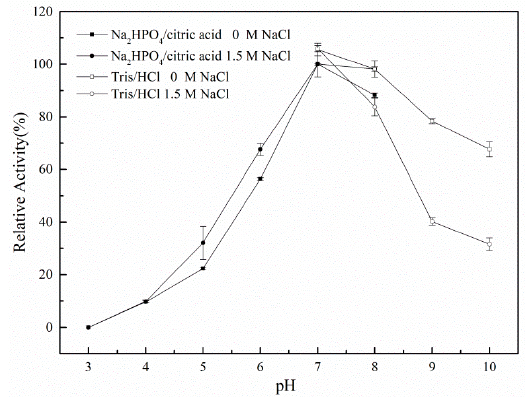
Figure 5. The influences of pH on the activity of the Xyl88.